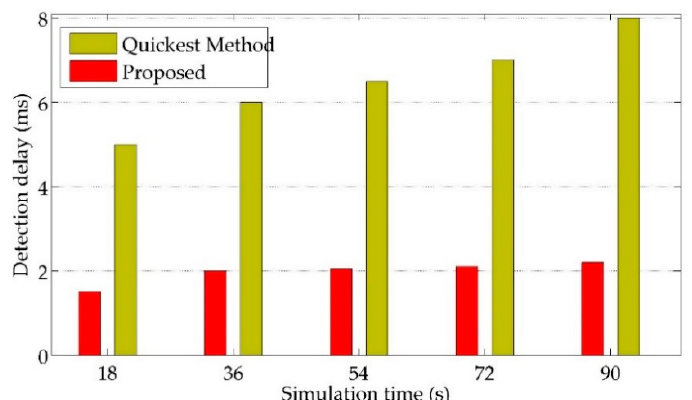
Figure 12. Analysis on detection delay.